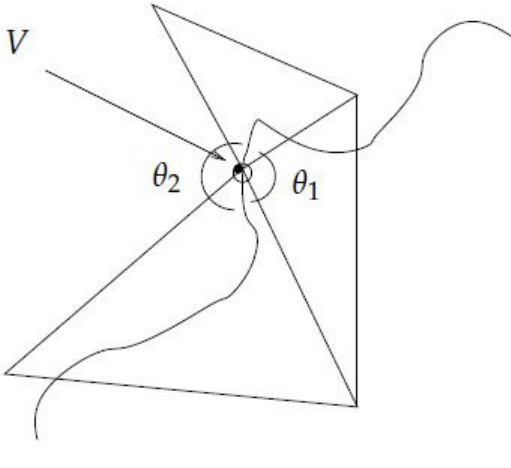
Figure 4. Straight curve at a